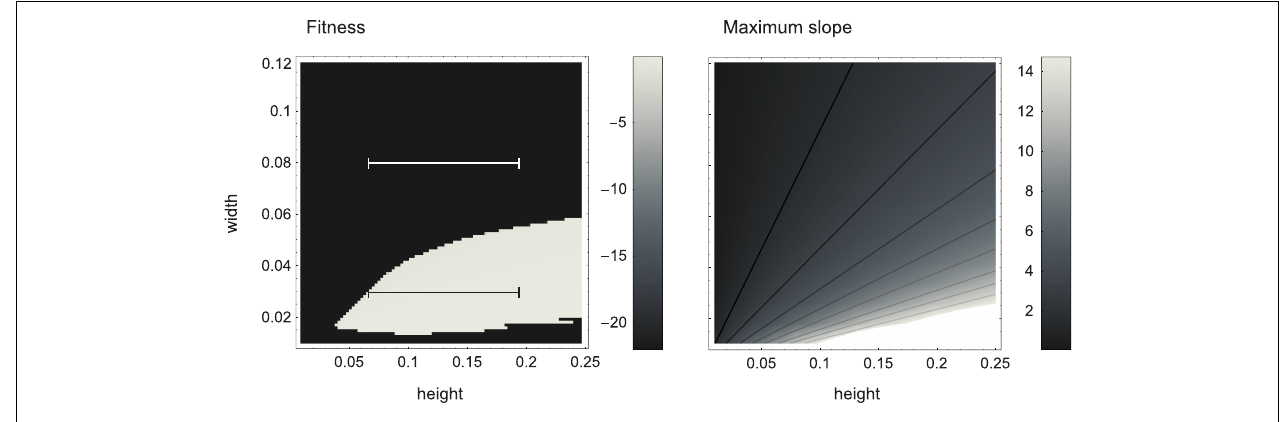
(widths = 0.03,0.08, height = 0.13 +− 50%). Right: maximum slope of the bell shape (derivative of corresponding Gaussian at w) covering the same range of width and height. Black lines trace equally spaced contours of constant slope.